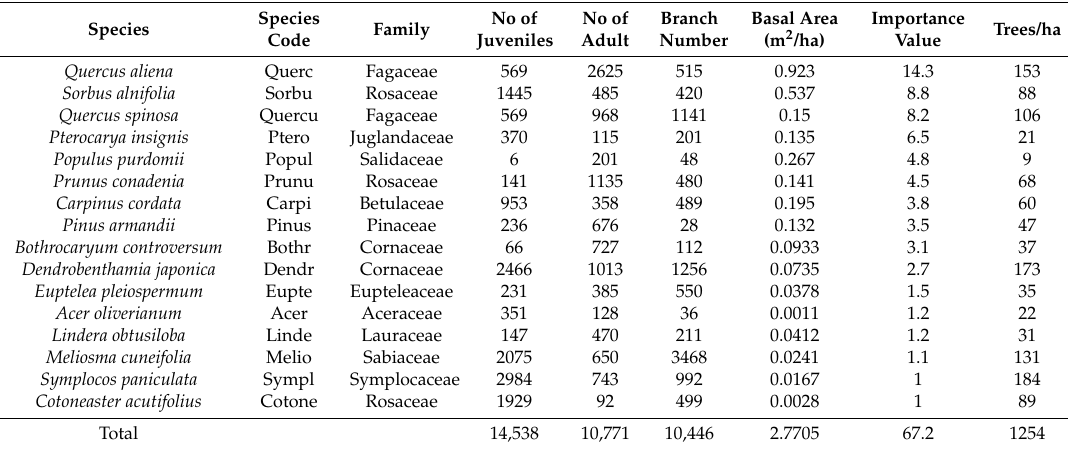
Table 1. The characteristics of the 16 dominant tree species in the 25-ha permanent forest dynamics plot in the Qinling Mountains, north-central